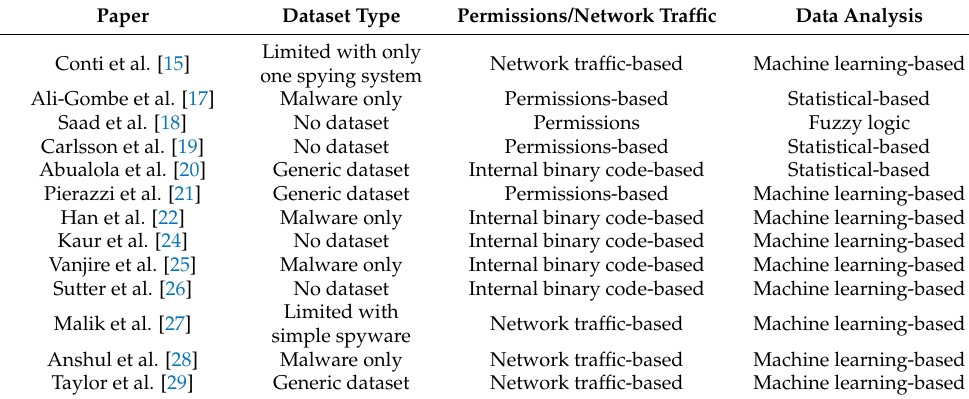
Table 1. Summary of the reviewed state-of-art in this area of study.